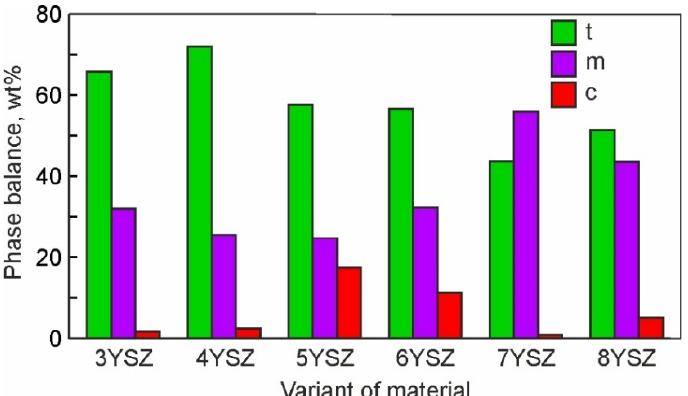
Figure 8. Phase balance for six studied materials with 3–8% Y 2 O 3 . Notation: t is tetragonal, m is monoclinic, and c is cubic ZrO 2 .